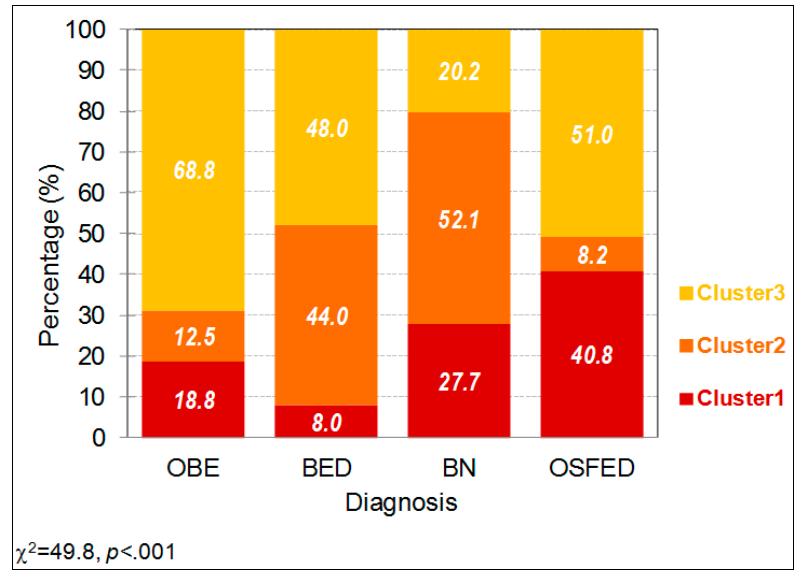
Figure 2. Distribution of the diagnostic subtype and the food addiction (FA) severity group within the empirical clusters. Note. OBE: obesity. BED: binge eating disorder. BN: bulimia nervosa. OSFED: other specified feeding eating disorder.